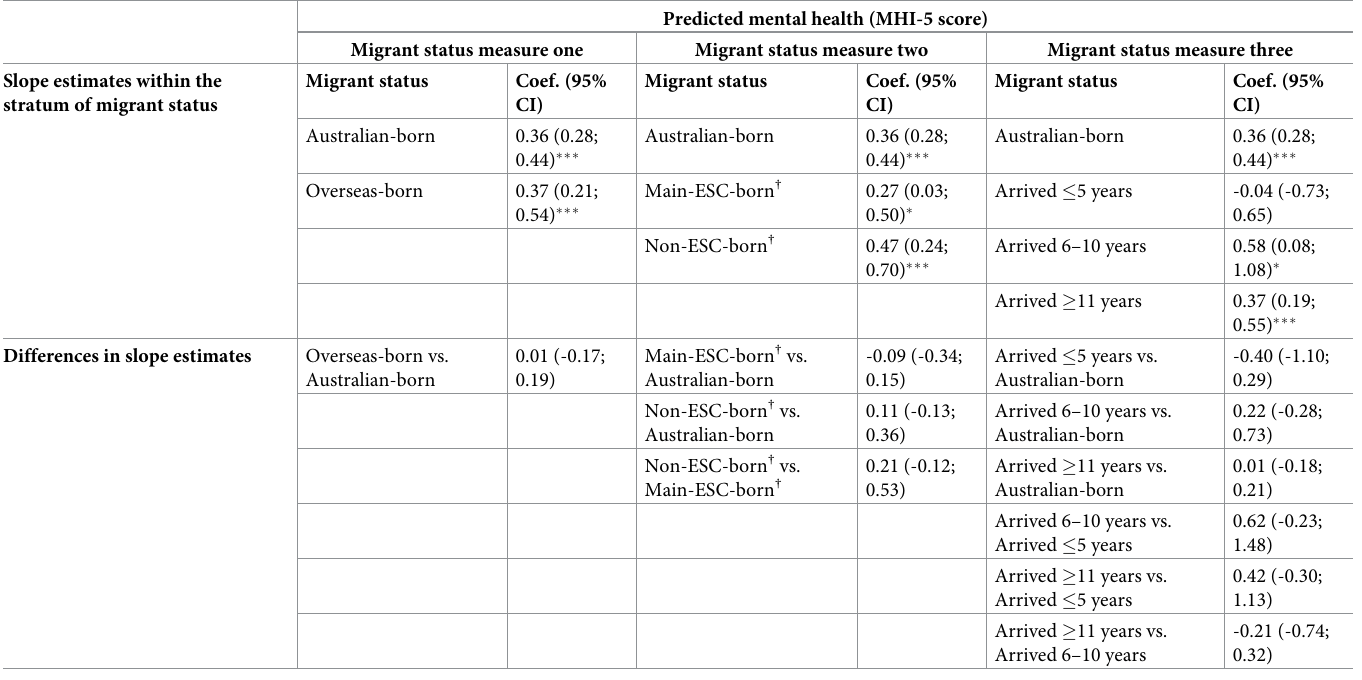
Table 4. Relationships between decision authority and mental health stratified by three measures of migrant status: The slope estimate within each stratum of migrant status and the differences in the slope estimates between groups, controlled for gender, age and educational